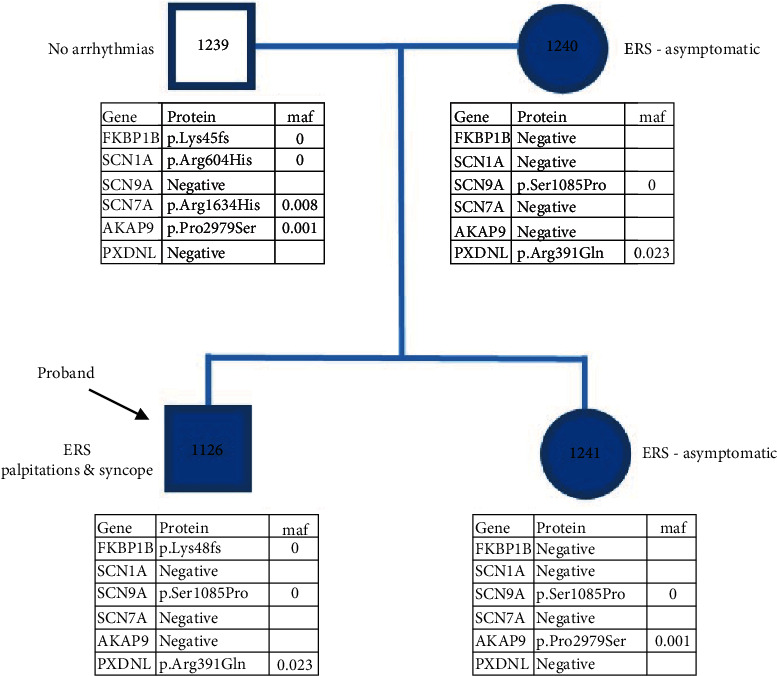
Pedigree of the proband (denoted with arrow) and family. Genetic analysis revealed that each parent carried different heterozygous mutation(s). The father (1239) carried the FKBP1b mutation, whereas the mother (1240) carried the PXDNL and SCN9A mutations. The sister of the proband (1241) only inherited the mutation in SCN9A. Both parents and the sister were asymptomatic.